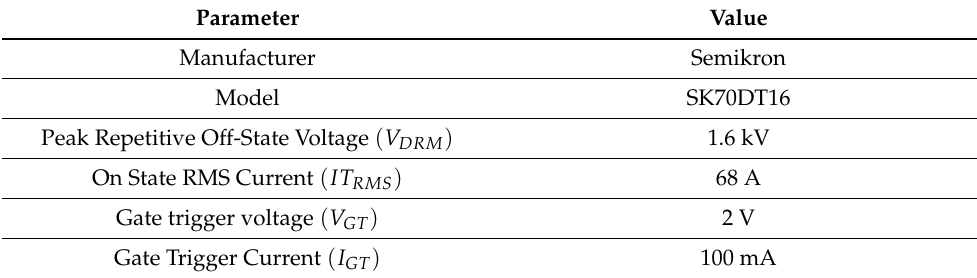
Table 2. Summary of three-phase fully controlled rectifier